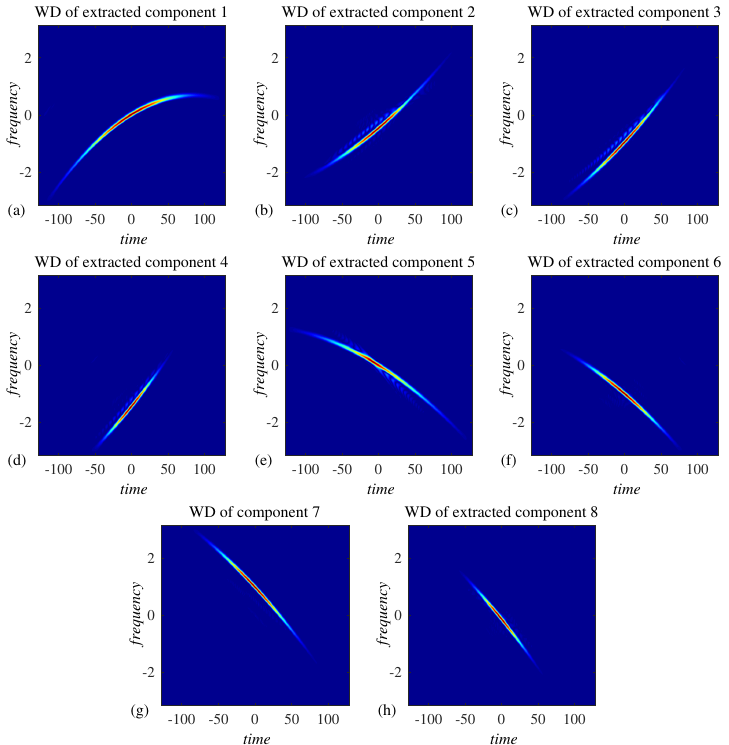
Figure 8. ( a – h ) Extracted signal components of the non-stationary multicomponent multichannel signal considered in Example 2. The decomposition is performed using the presented multivariate approach. The number of components is P =